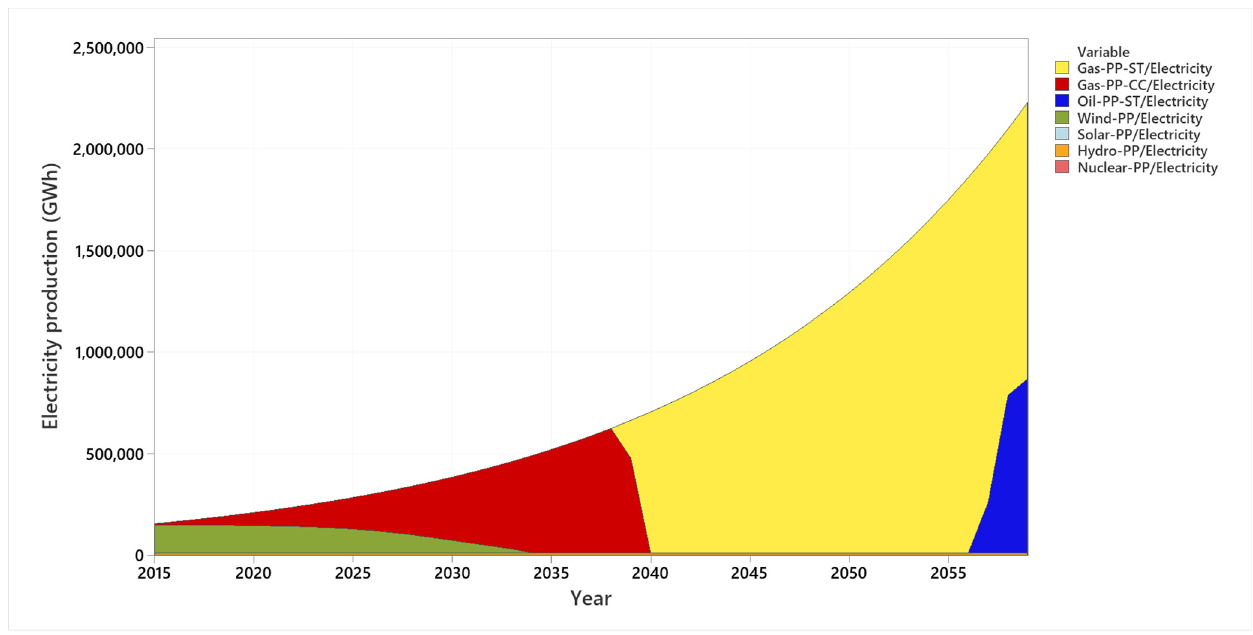
Figure 6. Balance of electricity production of all power plants for first scenario.